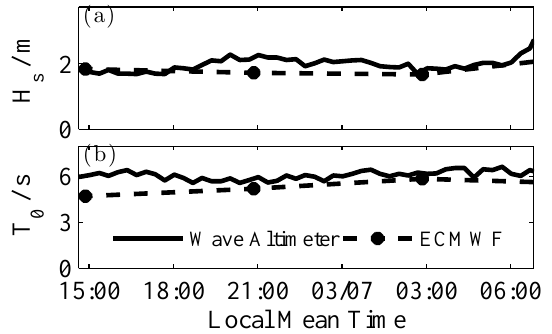
Fig. 4. Comparison of (a) significant wave height and (b) zero- upcrossing period for data collected with the ultrasonic wave al- timeter (solid line) and the ERA-Interim reanalysis of ECMWF (dots connected by dashed line). Time is in local mean time.